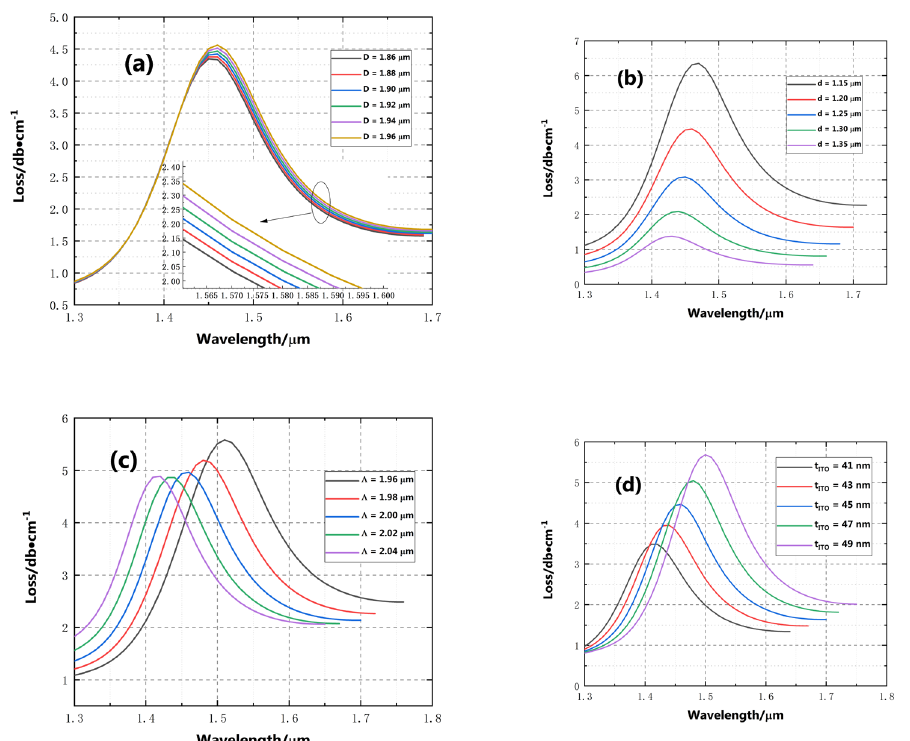
Figure 5. The effects of D , d , Λ , and t ITO on the loss spectra, H = 0 mT and T = 10 °C. ( a ) The diameter of large pores D . ( b ) The diameter of small pores d . ( c ) The distance between the adjacent pores Λ . ( d ) The thickness of ITO t ITO .